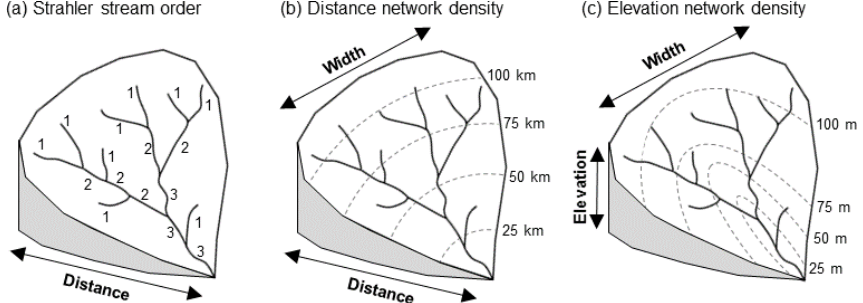
Figure 1. Topological metrics explored in this paper and the dimensions of the network they represent. (a) Strahler stream ordering repre- senting only the distance dimension of the network. (b) Distance network density representing the width dimension of the network at each distance interval (inspired by the network width function; Kirkby, 1976). (c) Elevation network density representing the width dimension of the network at each elevation interval (inspired by the link concentration function; Gupta et al.,